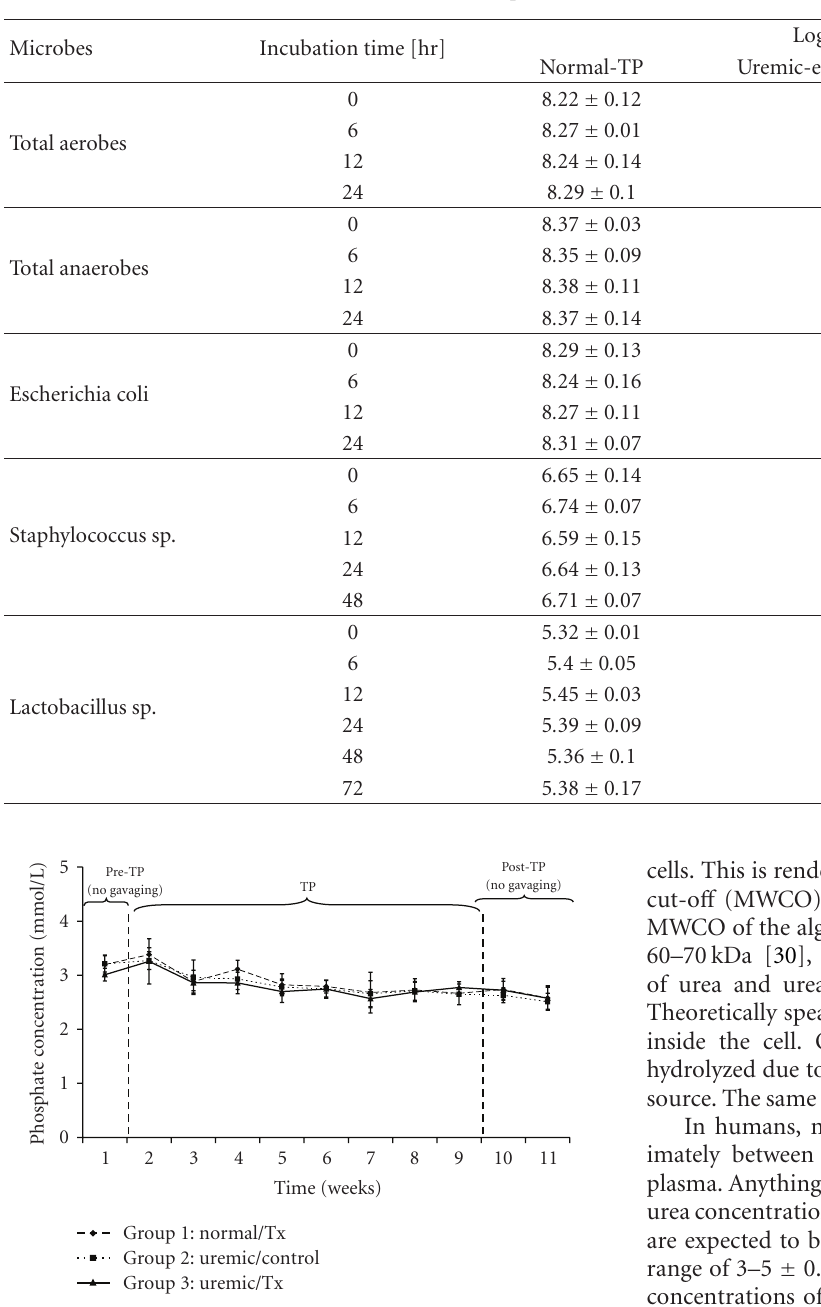
Figure 6: Plasma phosphate concentration before, during and after oral administration of APA microencapsulated yeast